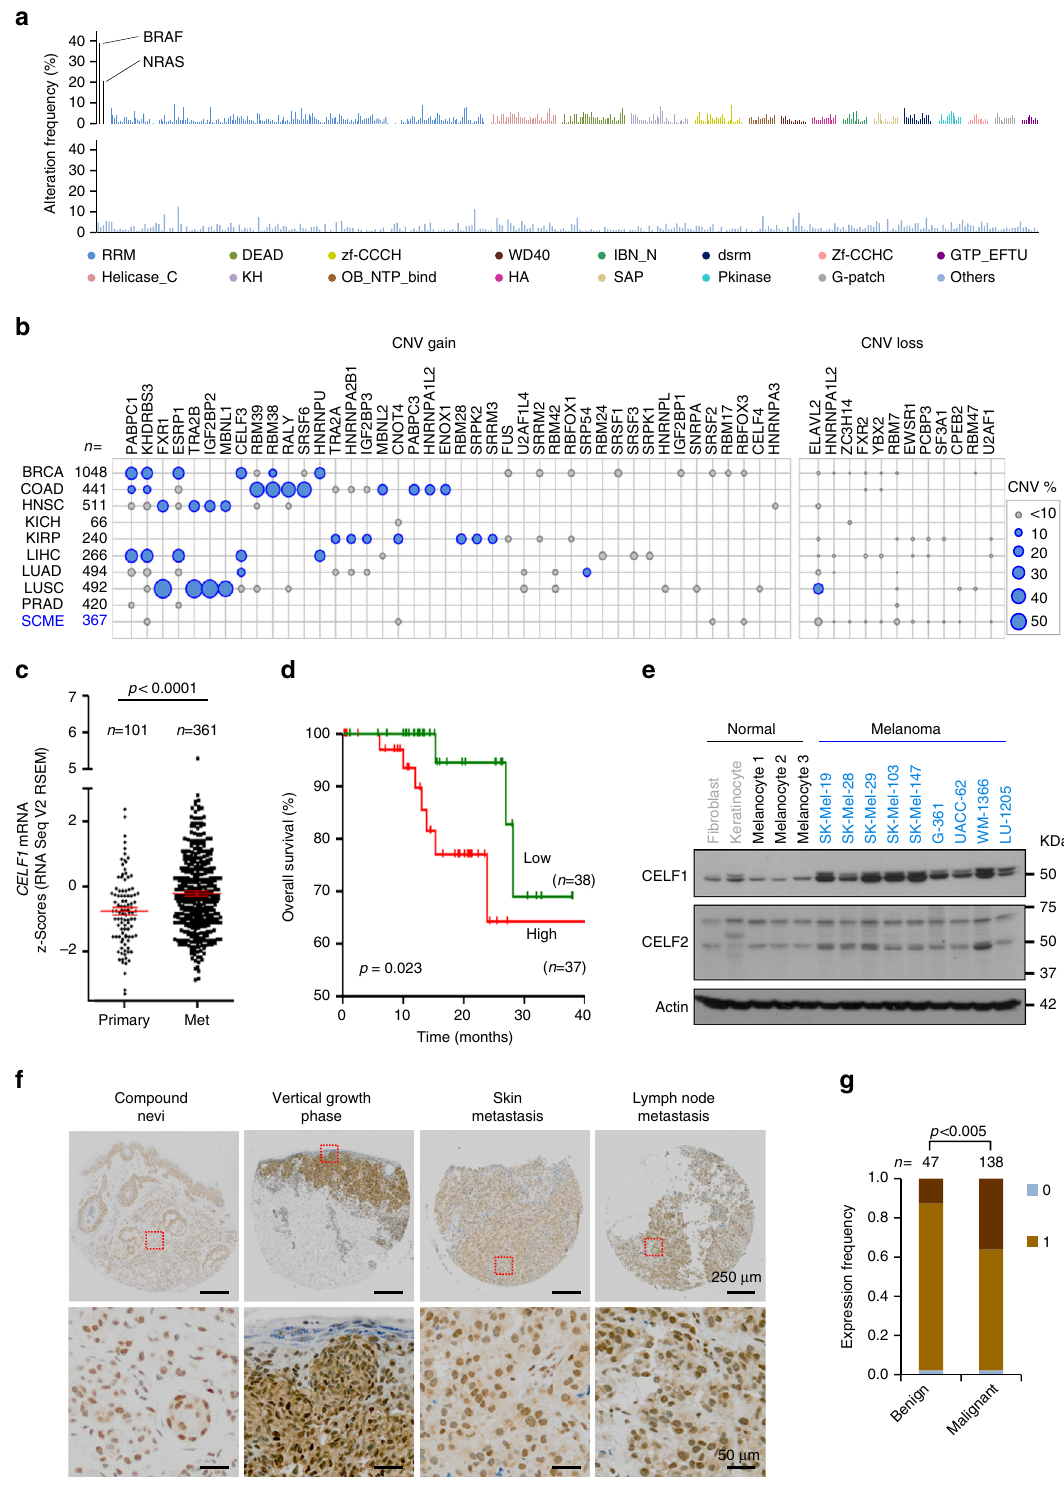
NATURE COMMUNICATIONS | 8: 2249 | DOI: 10.1038/s41467-017-02353-y |